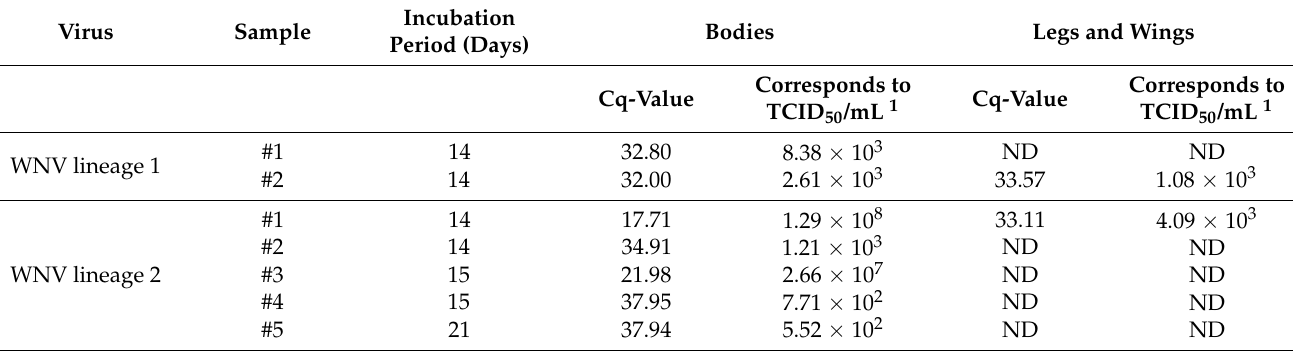
Table 2. Results of quantification by RT-qPCR of the viral load in mosquito bodies, legs and wings of Ae. punctor infected with WNV lineages 1 (strain Magpie/Italy/203204) and 2 (strain